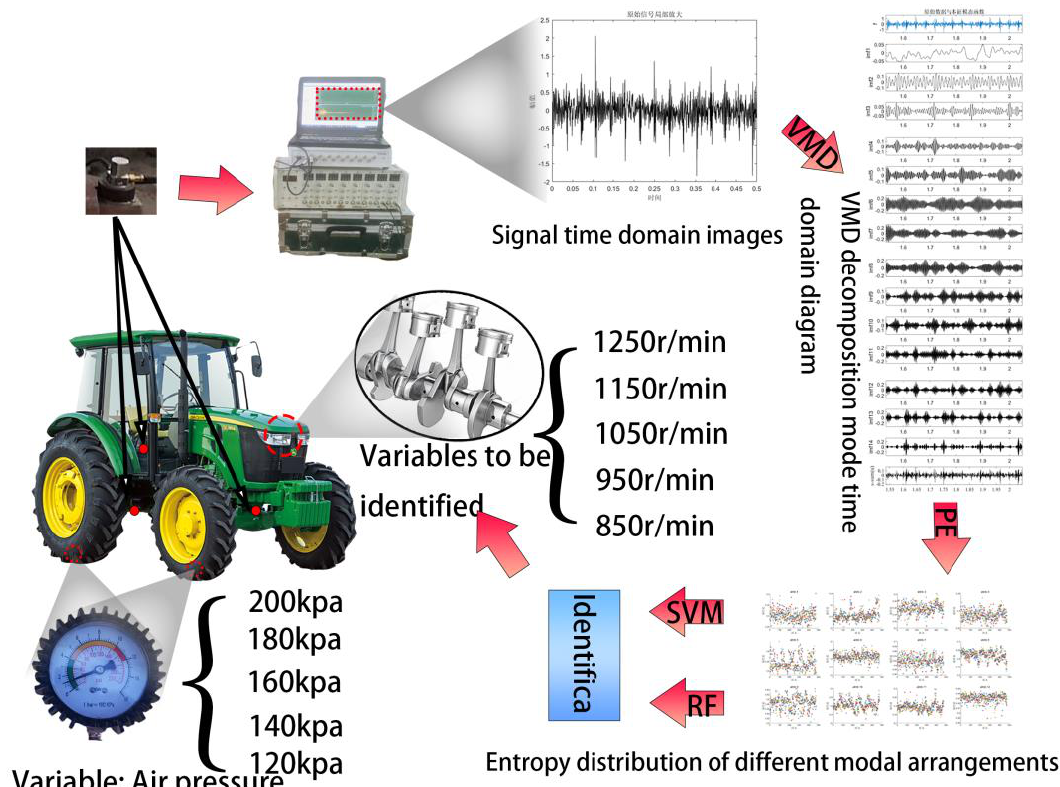
Figure 4. Flowchart of vibration signal analysis.